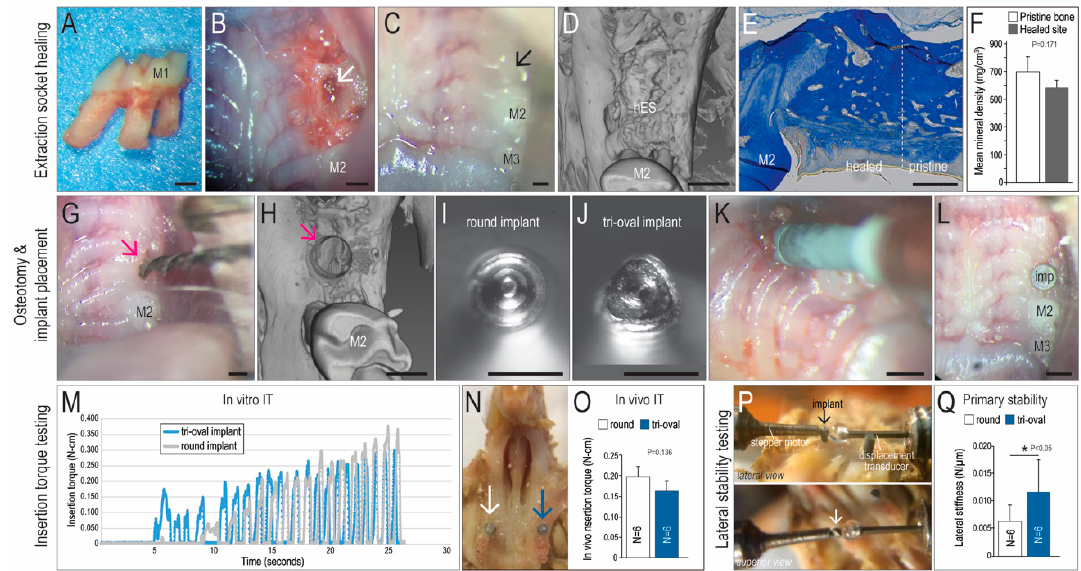
Figure 1. Tri-oval implants placed in type III bone with the same insertion torque exhibit higher primary stability as compared to conventional round implants. ( A ) Maxillary first molars (M1) were extracted from skeletally mature (8-week-old) male mice. ( B ) Intraoral photos of extraction socket (white arrow) and ( C ) Healed extraction site (black arrow). ( D ) Representative micro-CT imaging and ( E ) Representative aniline blue staining of the healed extraction socket on PED28. ( F ) Quantification of mean bone mineral density (BMD) on PED28, where the BMD of the healed extraction site was equivalent to surrounding pristine alveolar bone. ( G ) Osteotomies (0.45 mm dia.; pink arrow) were produced in the healed extraction sites using dental drill. ( H ) Representative micro-CT image of the prepared osteotomy site. ( I ) Geometries of the round and ( J ) tri-oval implants in cross-section. ( K ) Implant placement surgery. ( L ) Implants were positioned at the height of the gingiva. ( M ) In vitro IT testing and ( N ) In vivo IT testing where the white arrow indicates a round implant; blue arrow indicates a tri-oval implant. ( O ) Quantification of in vivo IT for round (white) and tri-oval (blue) implants. ( P ) Lateral stability testing of round and tri-oval implants (arrows) in the mouse maxillae; a stepper motor laterally displaces the implant a known amount while the force to do so is measured by a transducer. ( Q ) Tri-oval implants are significantly more stable than round implants at the time of insertion. Abbreviations: M1, maxillary first molar; M2, maxillary second molar; M3, maxillary third molar; hES, healed extraction site; PED, post-extraction day; imp, implant; IT, insertion torque. Scale bars = 500 µm.